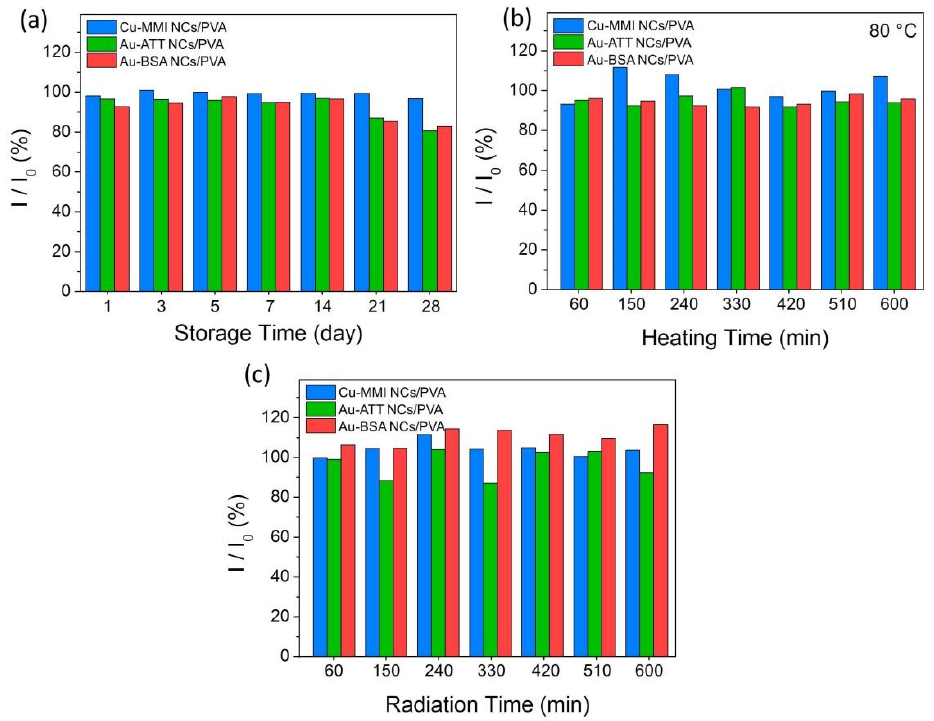
Figure 3. Stability of the Cu-MMI NCs/PVA film, Au-ATT NCs/PVA film, and Au-BSA NCs/PVA film: ( a ) storage stability, ( b ) thermal stability and ( c ) UV-irradiation stability.